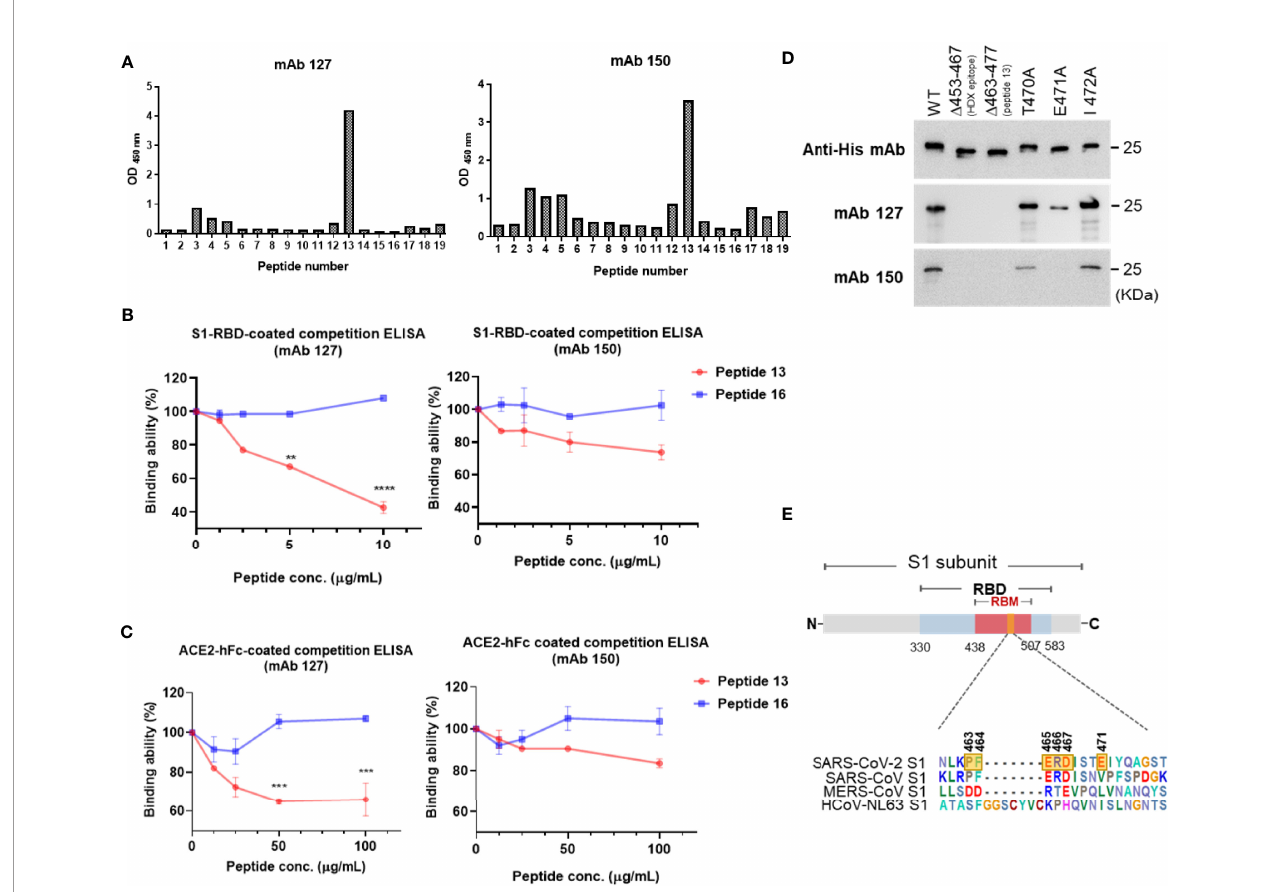
FIGURE 5 | Epitope mapping of the ACE2-cross reactive sequence on SARS-CoV-2 S1-RBD. (A) The binding ability of mAbs 127 and 150 (0.5 m g/mL) to 19 different SARS-CoV-2 S1-RBD polypeptides (2 m g/mL) was analyzed by indirect ELISA. Competition ELISA showing the blockage of the binding of mAbs 127 and 150 to (B) SARS-CoV-2 S1-RBD or (C) ACE2-hFc by different doses of peptide 13 and control peptide 16. The binding ability (%) represents the percentage of preincubated peptides to antibodies compared with that obtained without peptide preincubation. (D) One hundred nanograms of wild-type (WT) and fi ve different mutant His-tagged S1-RBD recombinant proteins, namely, HDX-MS sequence deletion ( D 453-467), peptide 13 deletion ( D 463-477), 470 mutant (T470A), 471 mutant (E471A), and 472 mutant (I472A), were separated by SDS – PAGE and then stained with 1 m g/mL anti-His mAb, mAbs 127 and 150. The binding ability was visualized by Western blotting. (E) The schematic sequence of the mAb epitope compared with the S1-RBD of four strains of CoV, namely, SARS-CoV-2 (YP_009724390.1), SARS-CoV (WH20 strain AAX16192.1), MERS-CoV (AFS88936.1), and HCoV-NL63 (APF29071.1), was aligned using BioEdit software. The epitope of mAb 127 is presented with six transparent yellow blocks (463, 464, 465, 466, 467, and 471) in the SARS-CoV-2 S1 sequence. All statistical data are presented as the means±S.Ds. from at least two independent experiments. **P<0.01, ***P<0.001,